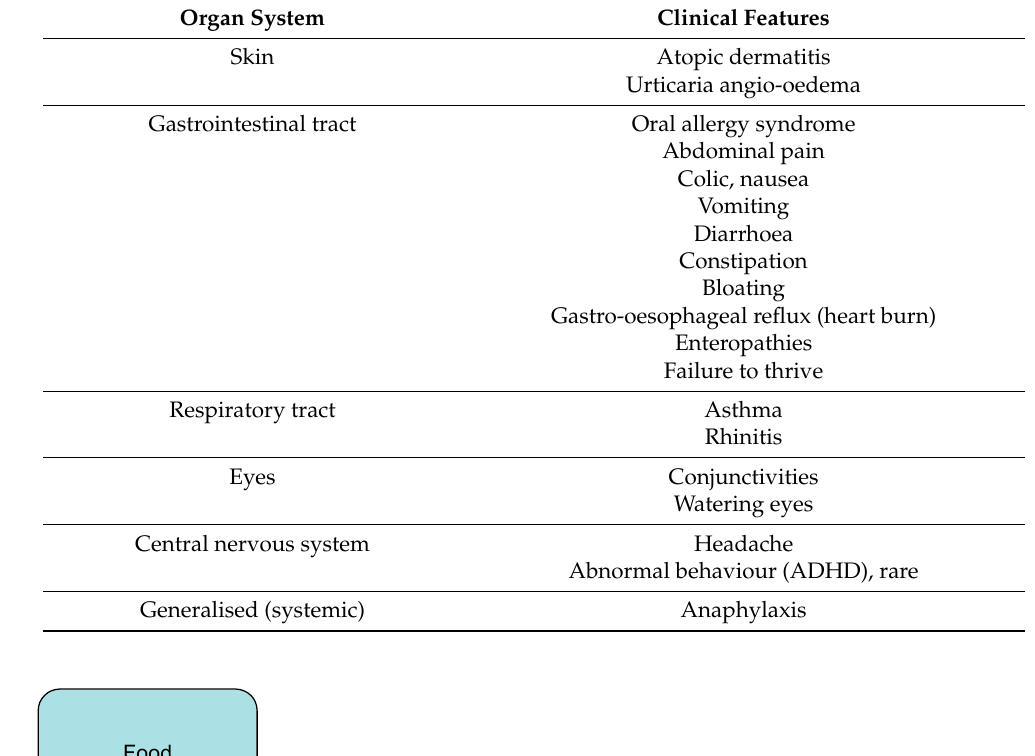
Table 2. Common clinical features of adverse reactions to food.